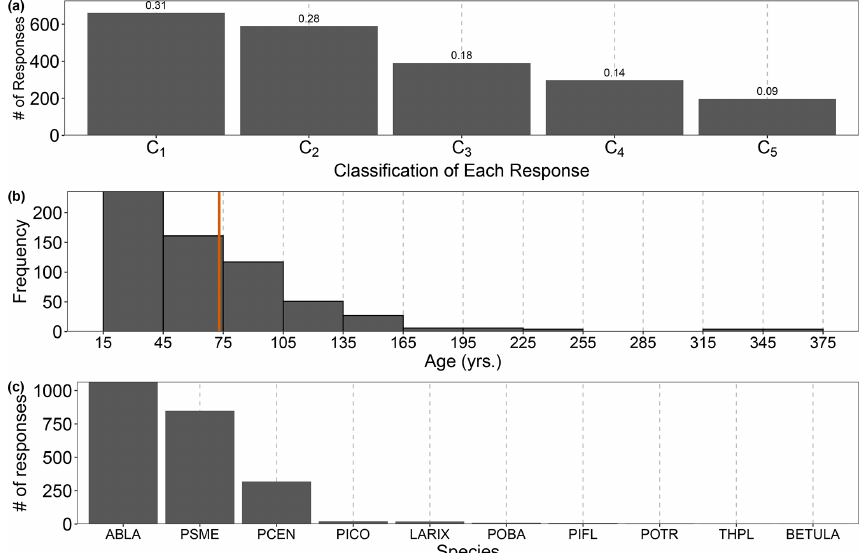
Figure 3. Histograms of (a) number of classification of responses (number above bar represents proportion), (b) sample age (red line repre- sents mean age), and (c) collected species. For the species, ABLA is Abies Lasciocarpa , PCEN is Picea engelmannii , PSME is Pseudotsuga menziesii , THPL is Thuja plicata , PICO is Pinus contorta , POTR is Populus tremuloides , LARIX is Larix Mill., BETULA is Betula L., and POBA is Populus balsamifera .